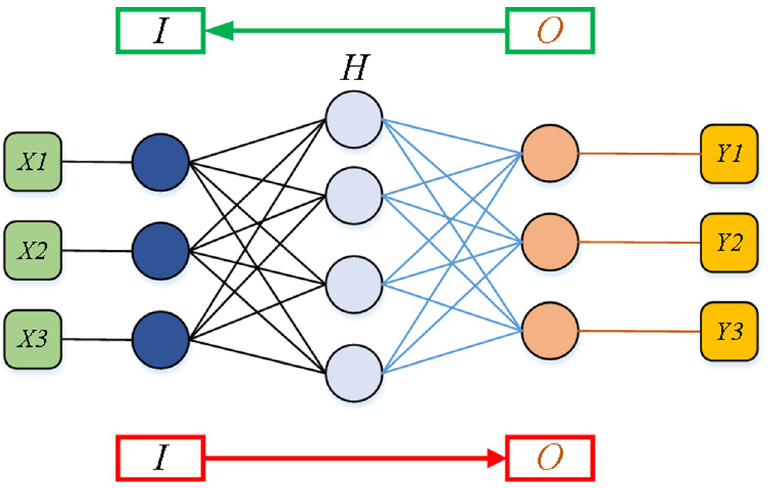
Fig 2. The forward propagation and backward propagation processes in